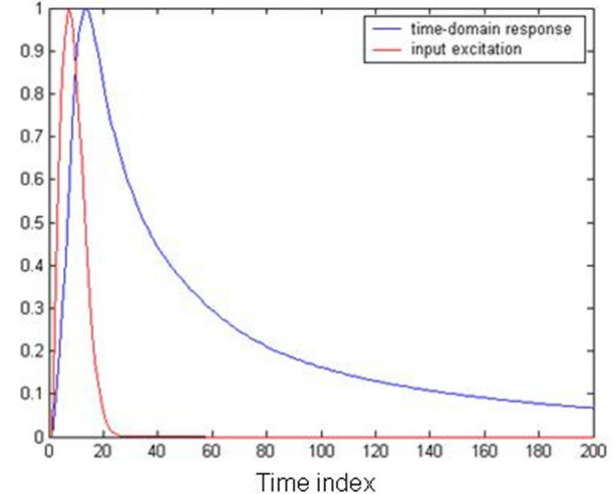
Figure 15. Normalized time-domain response of the electric flux density using the spectral